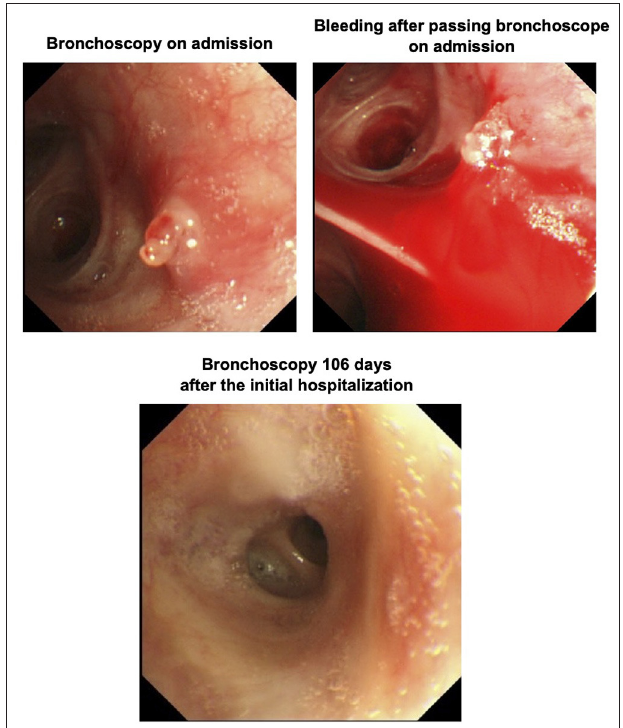
FIGURE 2 | Bronchoscopy performed on the day of admission showed a polypoid elevated lesion at the bifurcation of the left upper lobe (upper left panel). Passage of bronchoscope revealed pulsatile bleeding around the polypoid lesion (upper right panel). Bronchoscopy performed 106 days after the initial hospitalization revealed that the elevated lesion completely disappeared (lower panel).